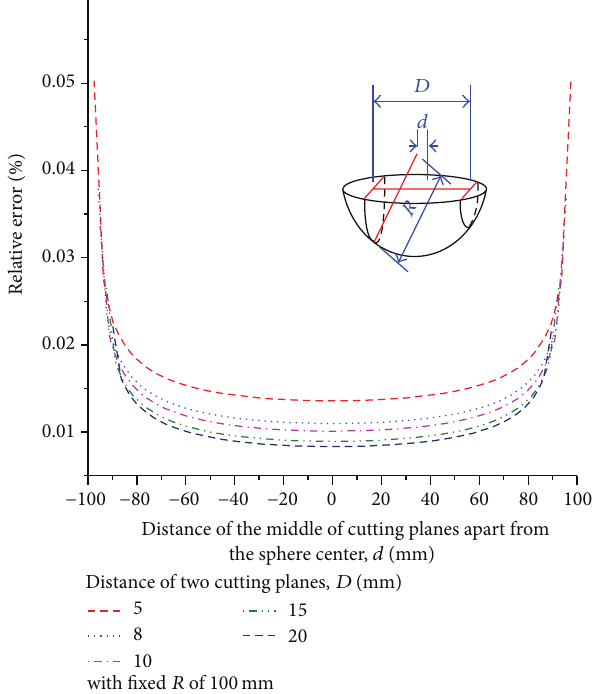
Figure 4: Profiles of the relative error for different mutual distance ( 𝐷 ) of cutting planes with the distance ( 𝑑 ) of the cutting planes center from the sphere center, where 𝑅 is ROC of the